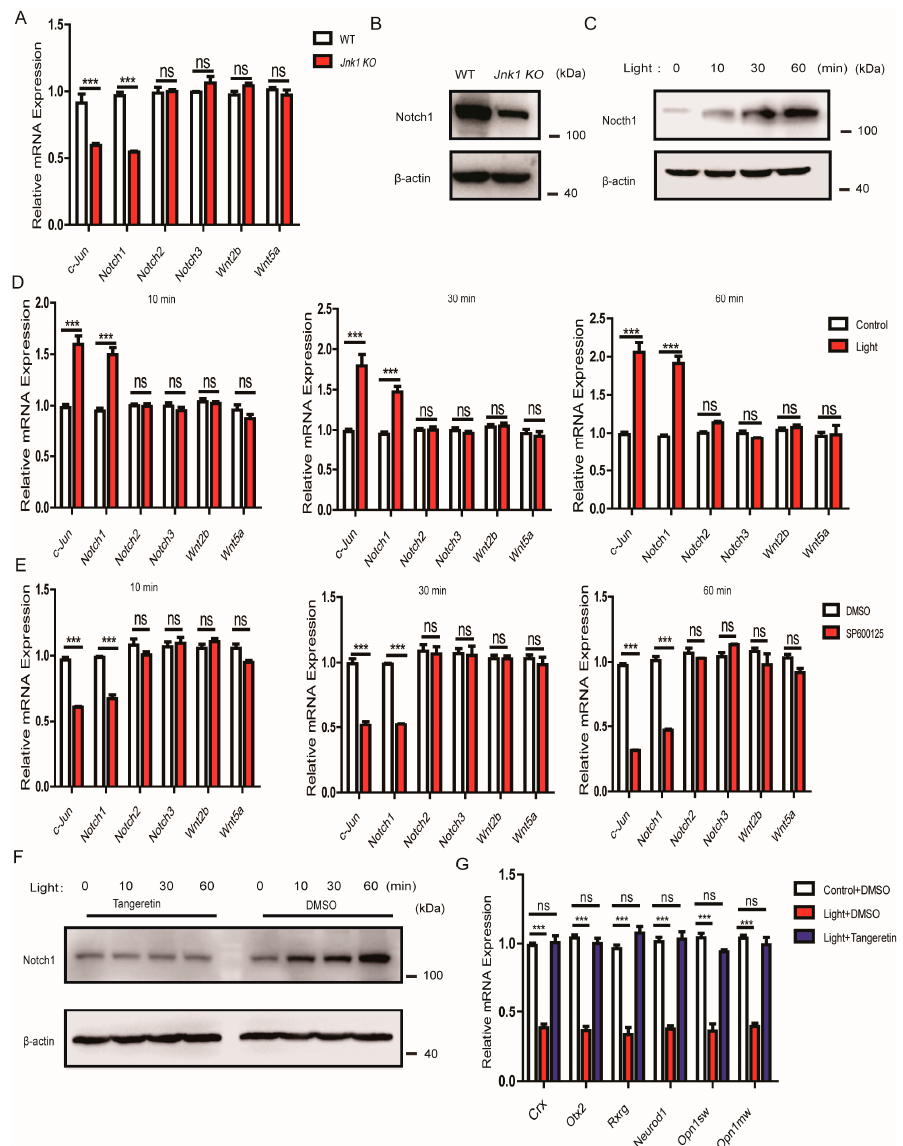
Figure 6. The function of JNK1 was dependent on Notch1. ( A ) Quantitative PCR analysis of c-Jun , Notch1 , Notch2 , Notch3 , Wnt2b , and Wnt5a mRNA in WT and Jnk1 KO retinas at P30. ( B ) Eyes were isolated from WT and Jnk1 KO mice at P30. Tissue homogenate was collected for western blot analysis using anti-Notch1. ( C ) Here, 661W cells were treated with light for the indicated times. Cell lysates were collected for western blot analysis of Notch1 and β -actin. ( D ) Here, 661W cells were treated with light for the indicated times, and 661W cells without light stimulation were a control. Then, the alternation of c-Jun , Notch1 , Notch2 , Notch3 , Wnt2b , and Wnt5a mRNA was measured by quantitative PCR. ( E ) Here, 661W cells were treated with DMSO and 20 μ mol/mL SP600125 for 2 h and were then treated by light for the indicated times. The alternation of c-Jun , Notch1 , Notch2 , Notch3 , Wnt2b , and Wnt5a mRNA was then measured by quantitative PCR. ( F ) Here, 661W cells were treated with DMSO and 50 µ mol / mL Tangeretin for 24 h and were then treated by light for the indicated times. Cell lysates were collected for western blot analysis of Notch1 and β -actin. ( G ) 661W cells were treated with DMSO and 50 µ mol / mL Tangeretin for 24 h and were then treated by light for the indicated times. The alternation of Rxrg , Neurod1 , Otx2 , Crx , Opn1sw , and Opn1mw mRNAs was measured by quantitative PCR. Graphs show the mean ± SEM, and the data (A,D,E,G) shown are representative of three independent experiments: ns, not significant; *** p < 0.001 (Wilcoxon–Mann–Whitney